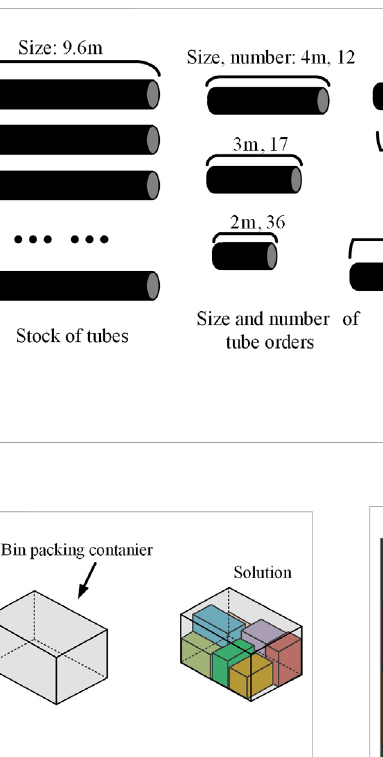
FIGURE 2 3D bin packing problem.